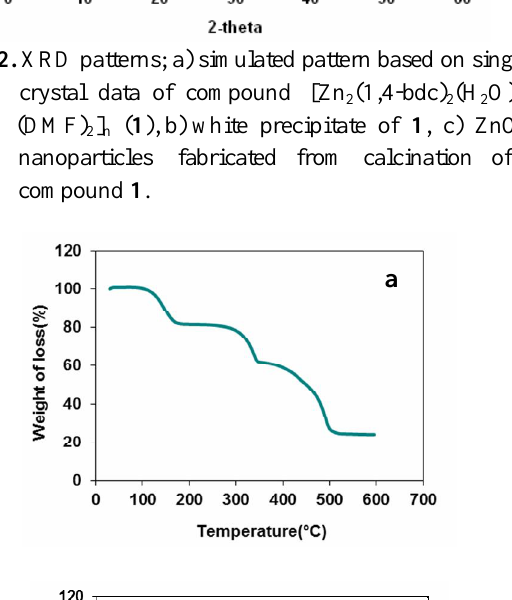
(1,4-bdc) (H O) ∙ 2 2 2 2